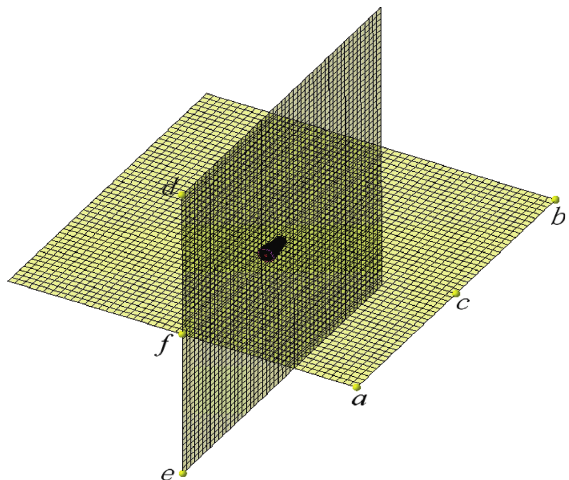
Figure 8: Six sample field points in the planar acoustic